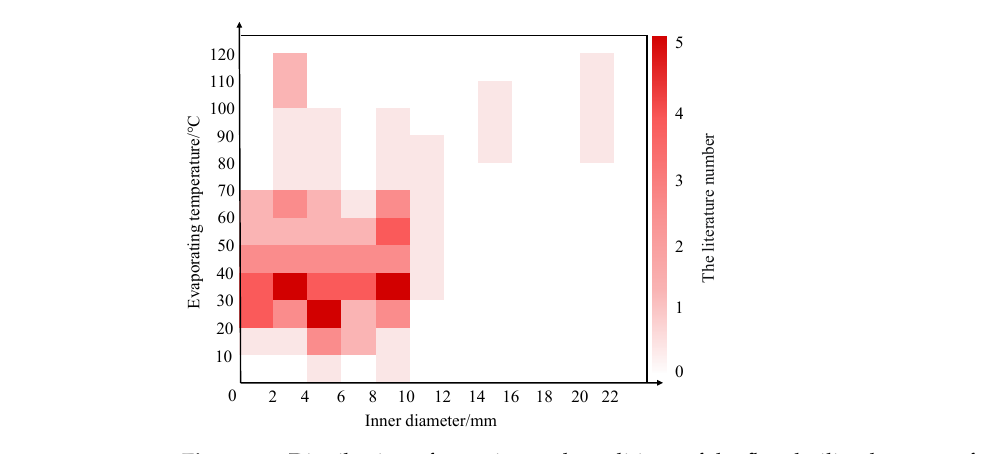
Figure 21. Distribution of experimental conditions of the flow boiling heat transfer characteristics of the ORC-recommended working fluid.